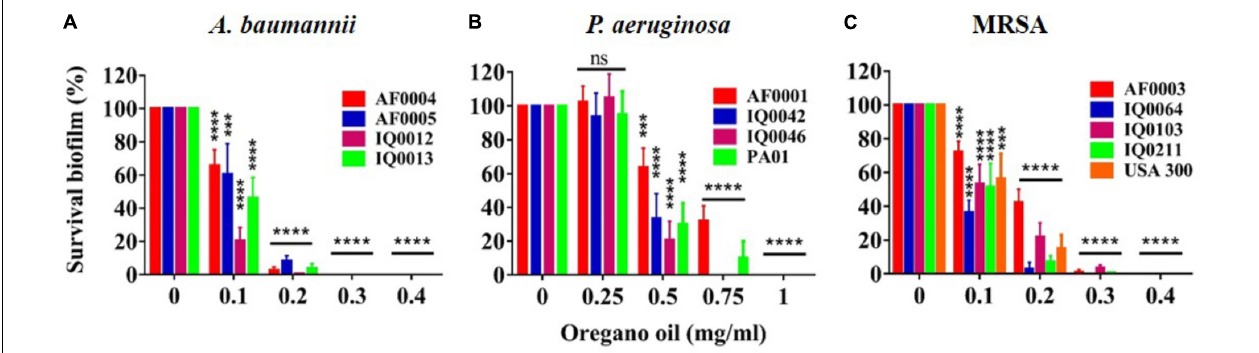
FIGURE 1 | Bacterial viability of 24 h-old-biofilms formed by MDR strains of A. baumannii (A) , P. aeruginosa (B) , and MRSA (C) after 1 h treatment with oregano oil at indicated concentrations. The viability of bacterial biofilms was determined using an Alamar Blue assay. Data represent means ± SDs. ∗∗∗ p < 0.001 and ∗∗∗∗ p < 0.0001 in the presence vs. absence of oregano oil. ns, no